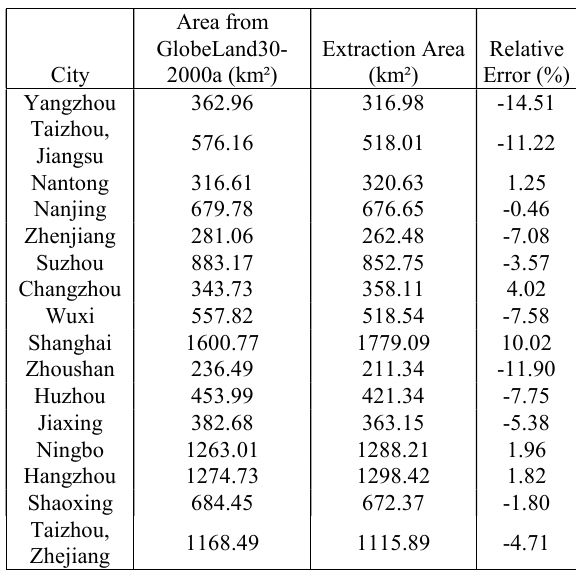
Table 1 . Relative error of urban built-up area in each city in Yangtze River Delta urban agglomeration.